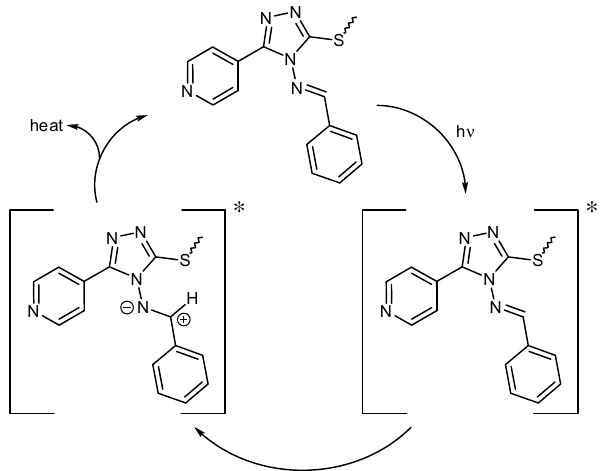
Scheme 1. Additives act as HCl scavengers.